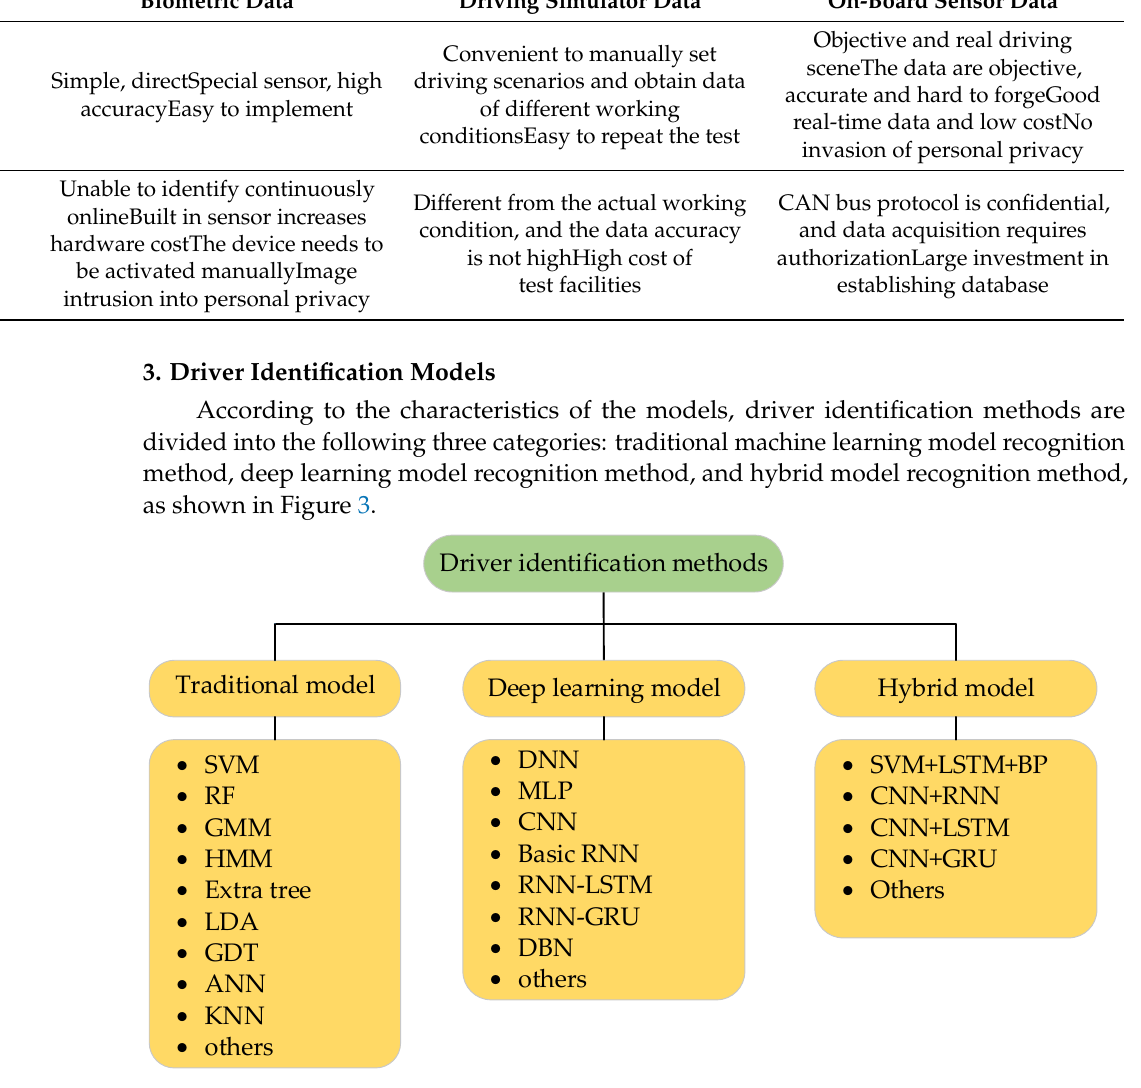
Figure 3. Classification of driver identification methods.